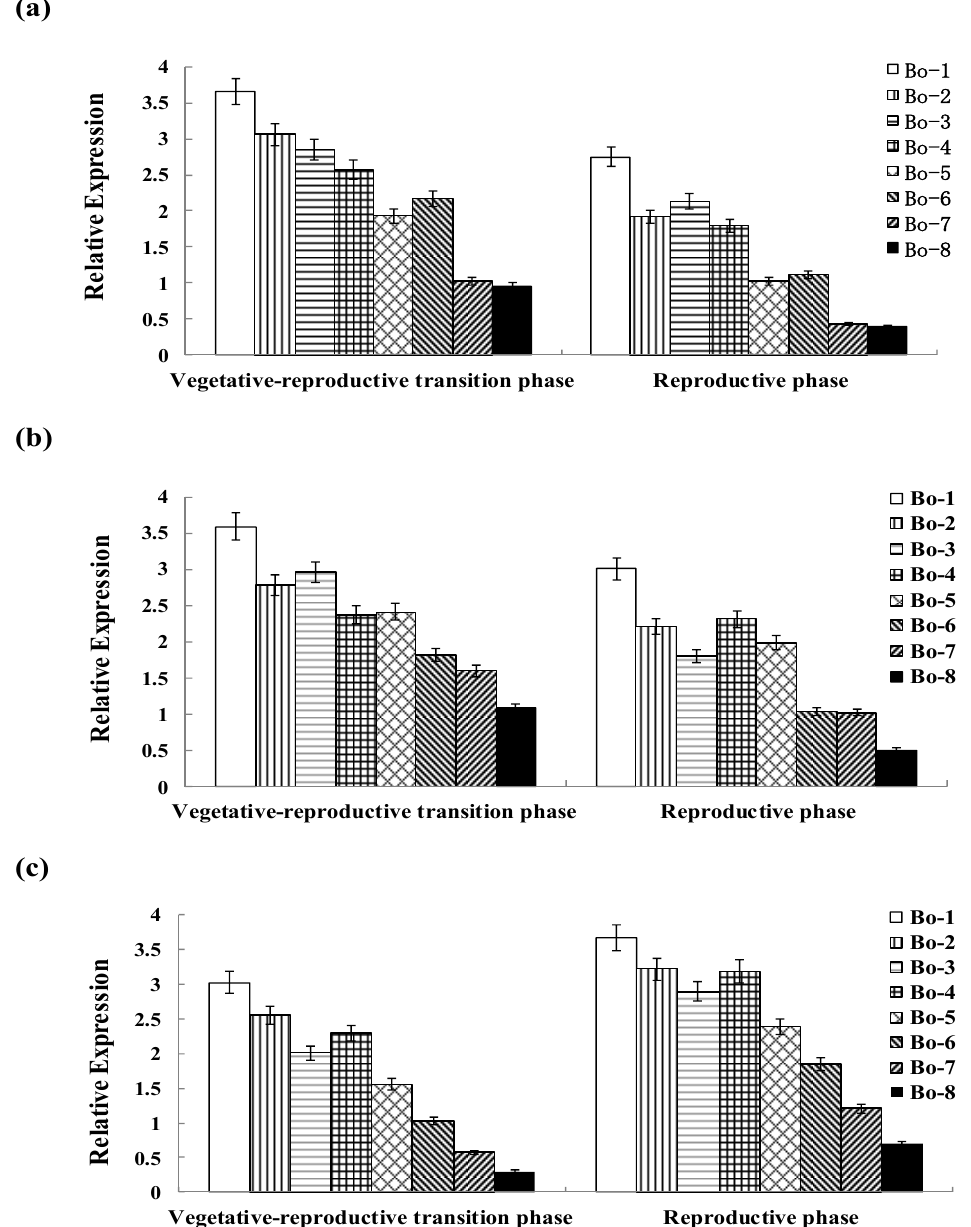
Figure 4. ( a ) Genotypic expression patterns of BCAT4 ; ( b ) Genotypic expression patterns of MAM1 ; ( c ) Genotypic expression patterns of CYP79F1 . The stages are defied as: vegetative–reproductive transition phase (the elongated stems) and reproductive phase (stems with inflorescence). Each bar represents the mean (±standard error) of three independent biological replicates.